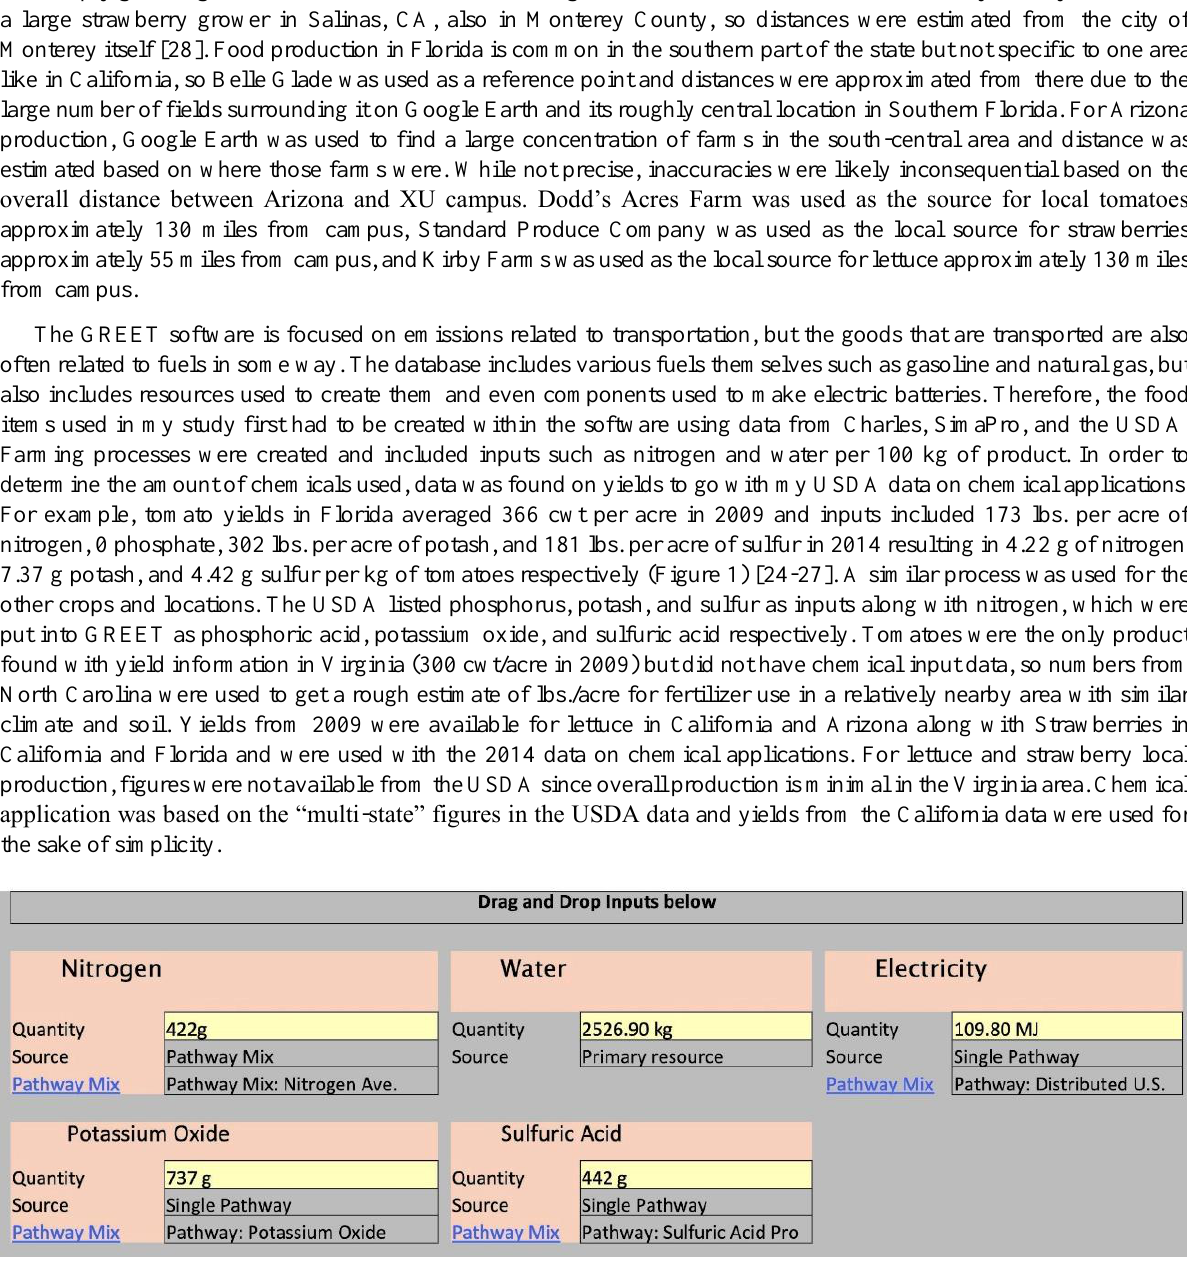
Figure 1. Florida raised tomato inputs to the GREET